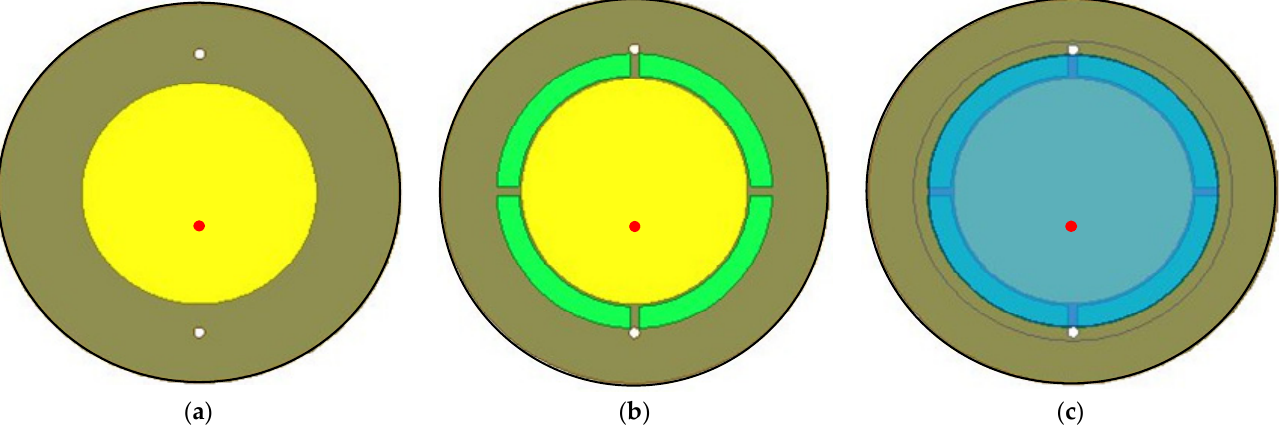
Figure 2. The evolution of the proposed tri-band patch antenna: ( a ) Ant. 1; ( b ) Ant. 2; ( c ) Ant. 3.